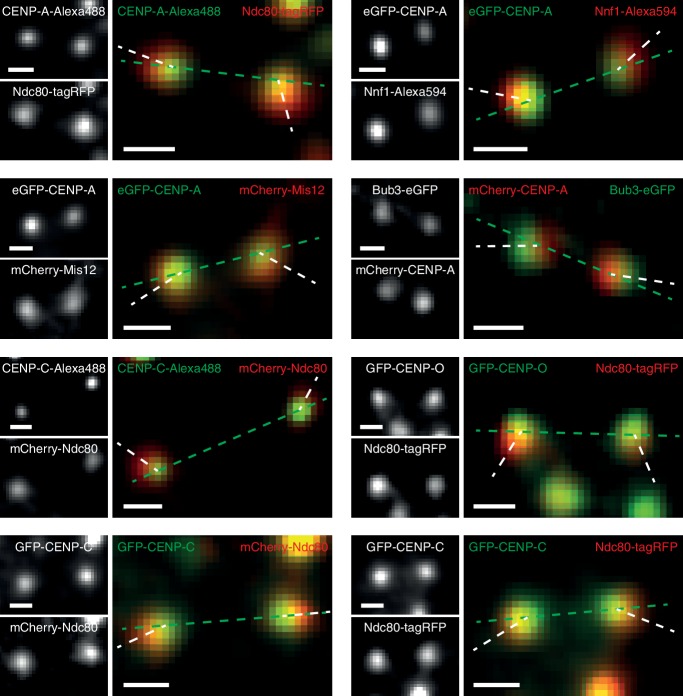
Kinetochore swivel is also present between other pairs of kinetochore markers.Example images of other pairs of kinetochore proteins tagged by fluorescent markers with visible swivel, including (clockwise from top left): CENP-A-Alexa488 and Ndc80-tagRFP; eGFP-CENP-A and Nnf1-Alexa594; Bub3-eGFP and mCherry-CENP-A; GFP-CENP-O and Ndc80-tagRFP; GFP-CENP-C and Ndc80-tagRFP; GFP-CENP-C and mCherry-Ndc80; CENP-C-Alexa488 and mCherry-Ndc80; and eGFP-CENP-A and mCherry-Mis12. Green dashed lines are the sister-sister axes, white dashed lines are intra-kinetochore axes. Scale bars 500 nm.